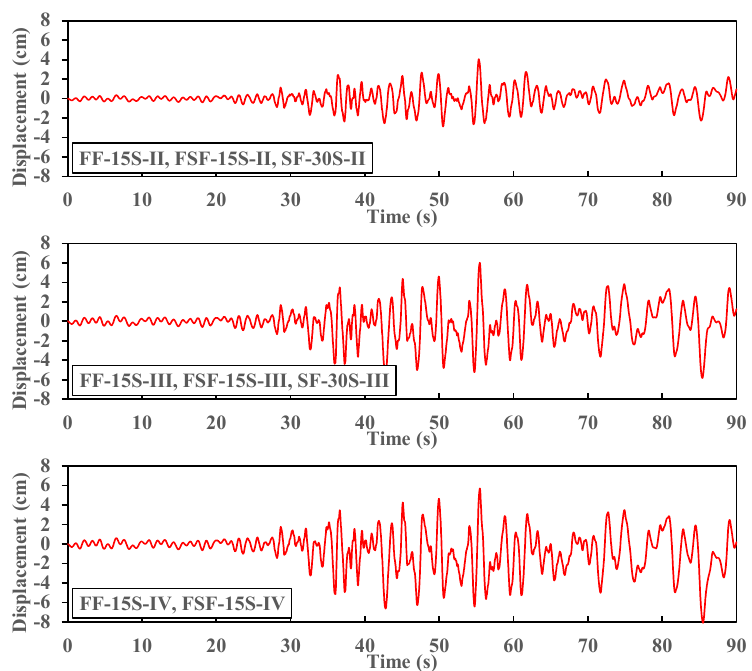
Figure 6. Seismic displacement control applied to column structures.